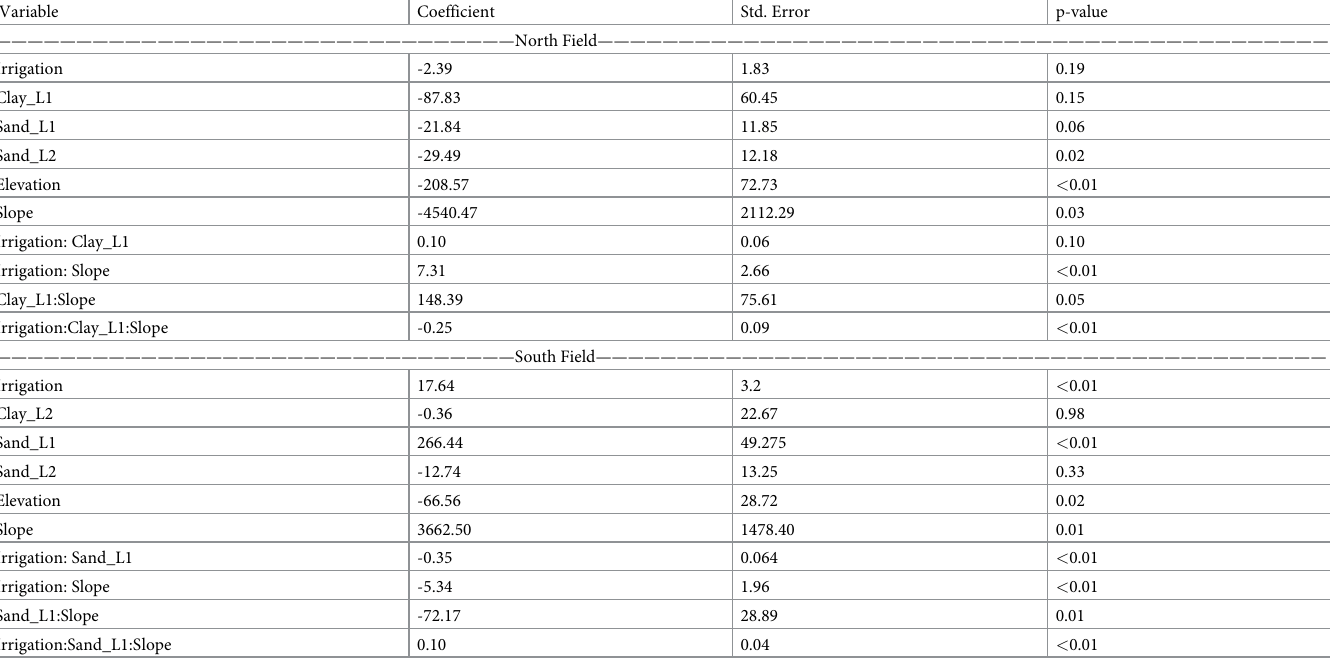
Table 2. Linear mixed-effects model for predicting cotton lint yield using irrigation rates, soil properties, and topography in two fields within a 194-ha farm in Hale County, Texas in 2017. Coefficient Std.